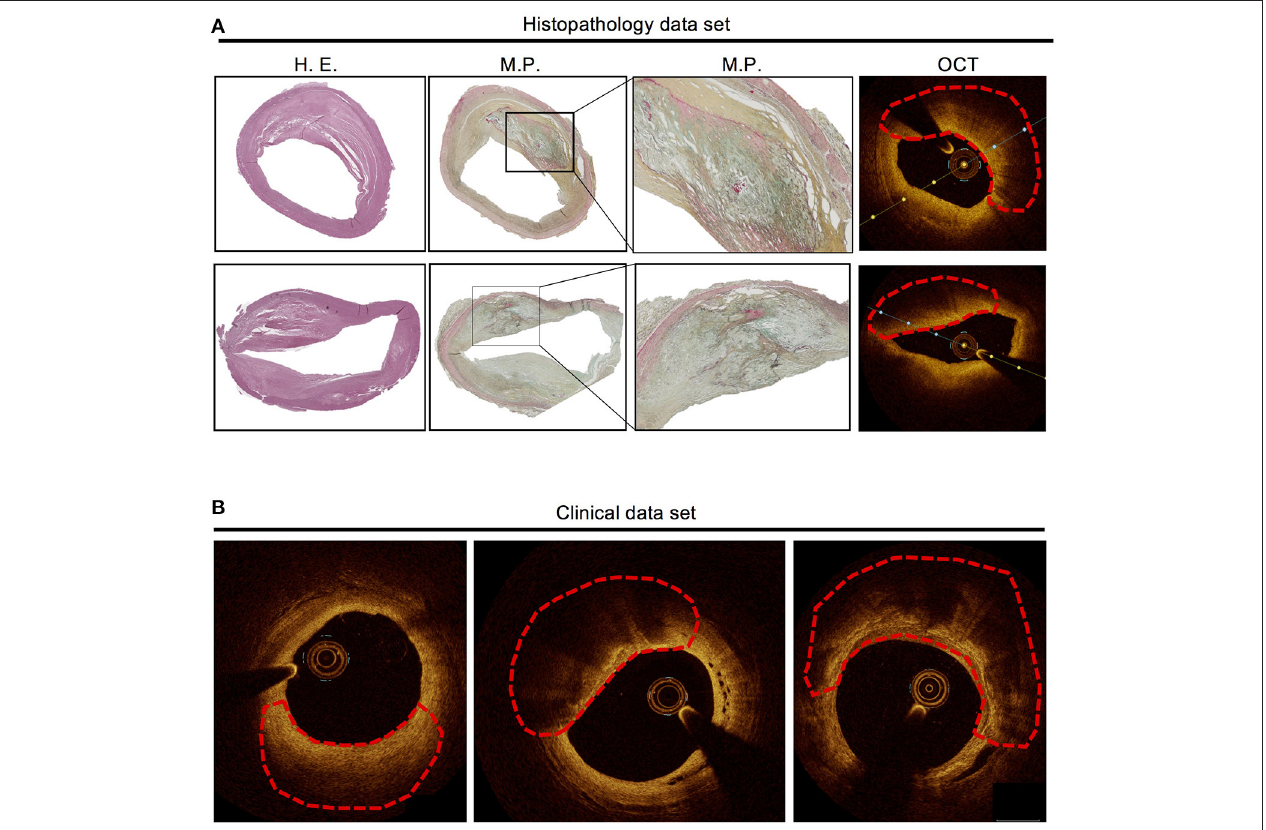
FIGURE 3 | Examples from the histopathology data set and the clinical data set. (A) Histopathology of two atherosclerotic lesions (fibroatheroma with necrotic core covered by fibrous cap) with manual annotation (marked by red dashed line) and co-registered OCT frames. (B) Three examples of atherosclerotic lesions in clinical OCT images (marked by red dashed line), based on clinical judgement without underlying histopathology. Left: fibrotic plaque, middle: lipid plaque, right: calcified plaque.